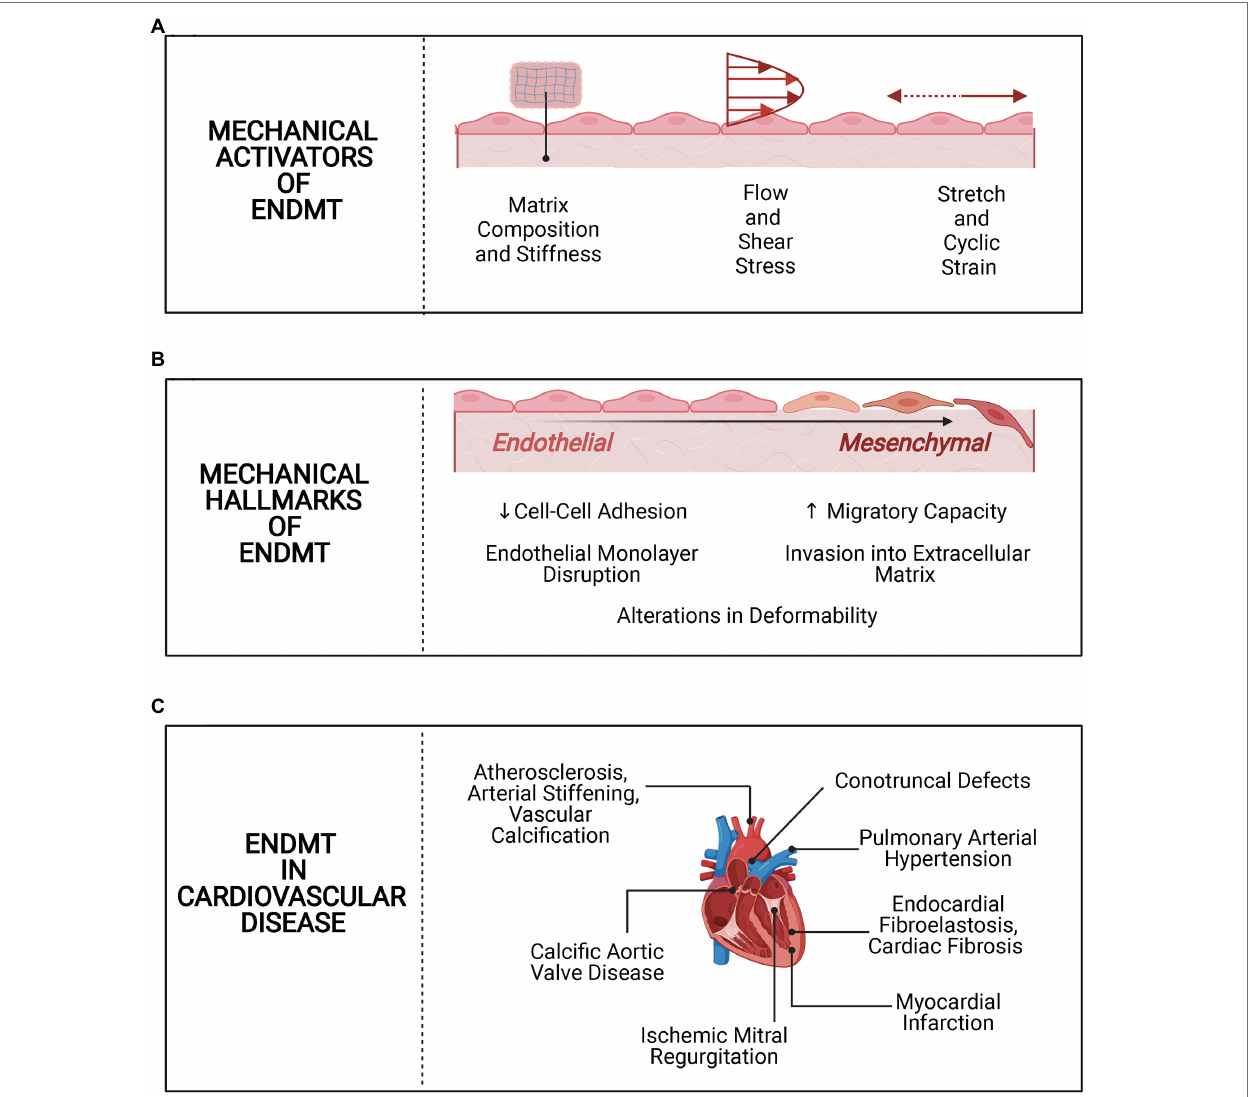
FIGURE 1 | Overview of mechanobiology of endothelial-to-mesenchymal transition (EndMT) in cardiovascular disease (CVD). (A) Mechanical activators of EndMT. Alterations in matrix stiffness and composition, shear stress, and cyclic strain activate EndMT in endothelial cells. (B) Mechanical hallmarks of EndMT. Following activation of EndMT, there are mechanical changes, such as loss of cell-cell adhesion and increased migration. (C) EndMT in CVD. EndMT is implicated in several CVD processes, with a potential role for biomechanical alterations in